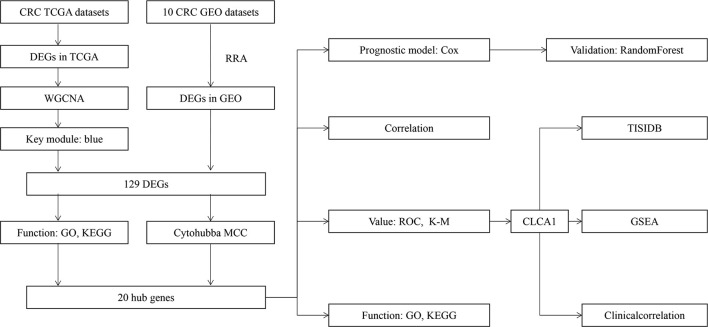
Analysis workflow of this study.